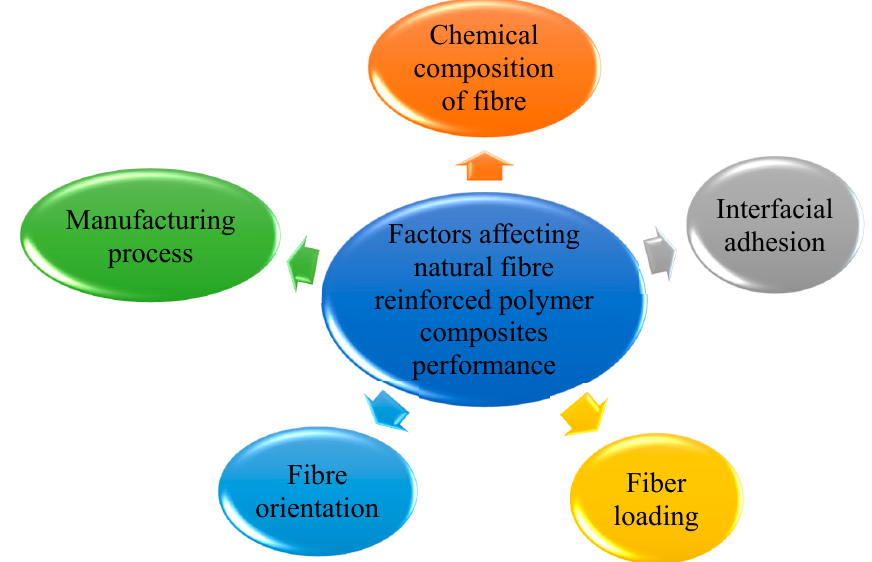
Figure 4. Factors that influence the composite performance. Table 3. Fiber types and their scientific name [6–28].